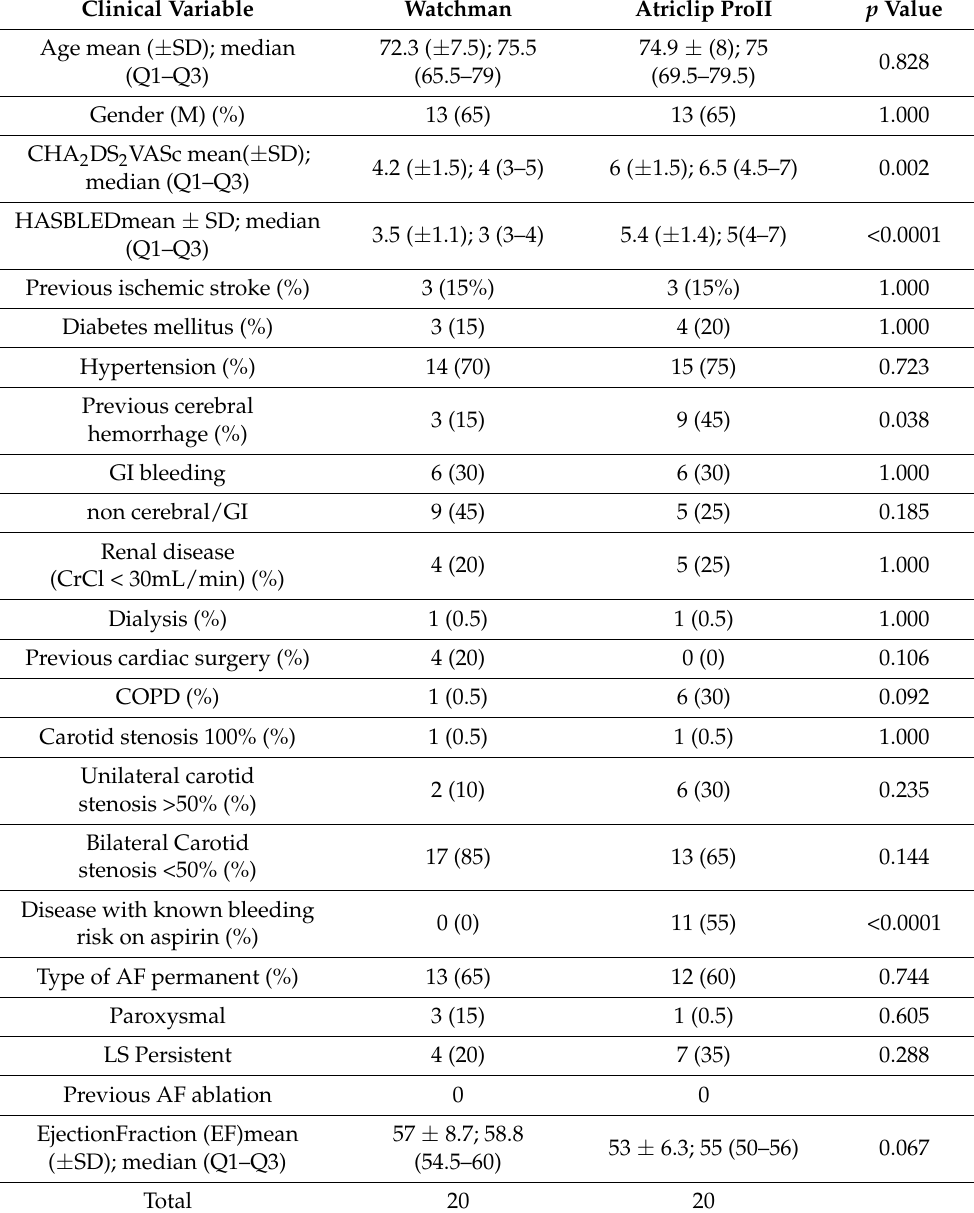
Table 1. Patients